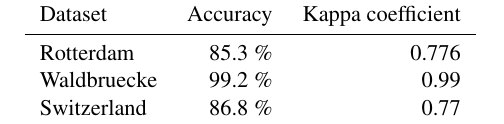
Table 4: Total number of aggregated